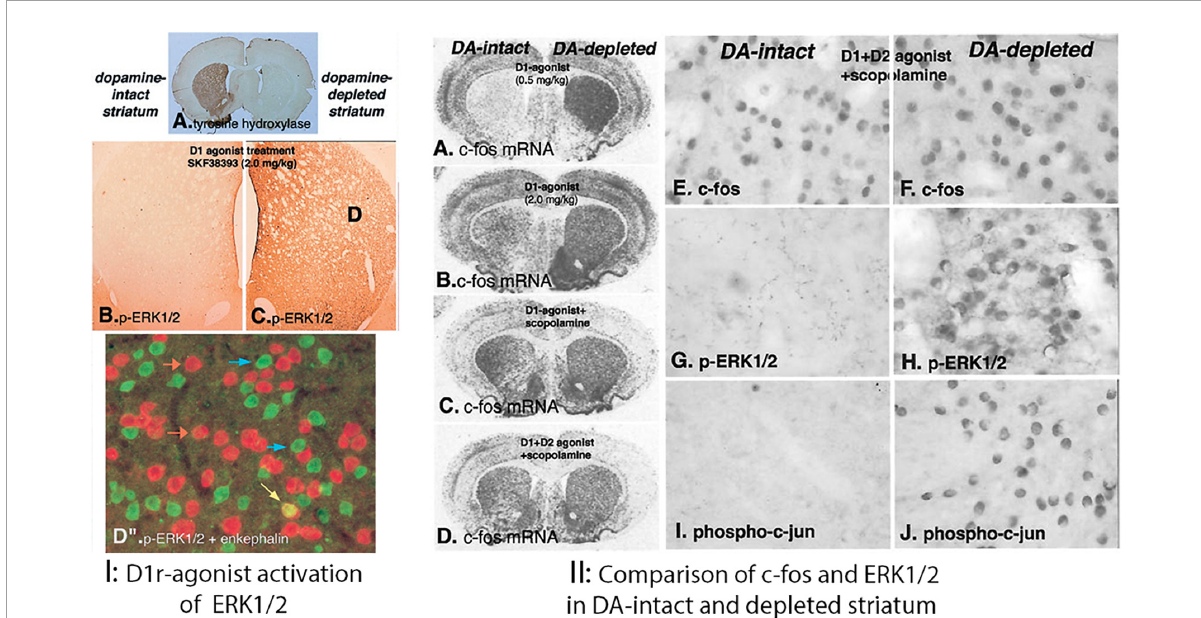
FIGURE4 (I) D1 dopamine receptor-mediated phosphorylation of ERK1/2 (p-ERK1/2) in the dopamine-depleted striatum. Unilateral lesion of the nigrostriatal dopamine systems is demonstrated by the loss of tyrosine hydroxylase immunoreactivity in the right lesioned striatum (A) .